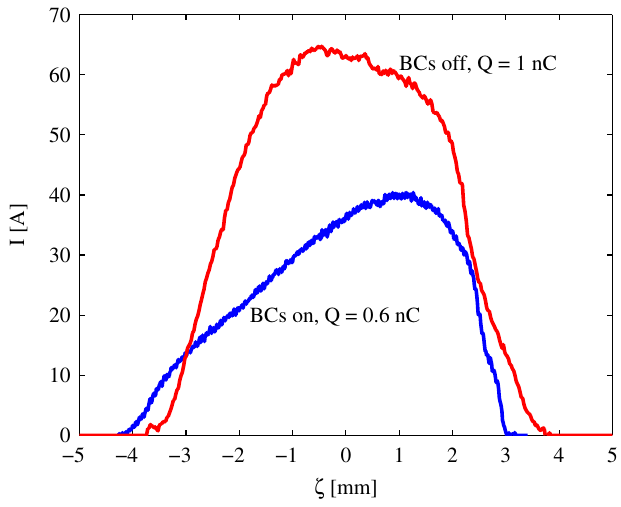
FIG. 8. (Color) Beam current I as a function of the internal bunch coordinate (cid:2) for on-crest operation of all acceleration modules. Red curve: dipoles of the magnetic chicanes switched off ( E ¼ 650 MeV , Q ¼ 1 : 0 nC ). Blue curve: dipoles of the bunch compressor chicanes switched on ( E ¼ 490 MeV , Q ¼ 0 : 6 nC